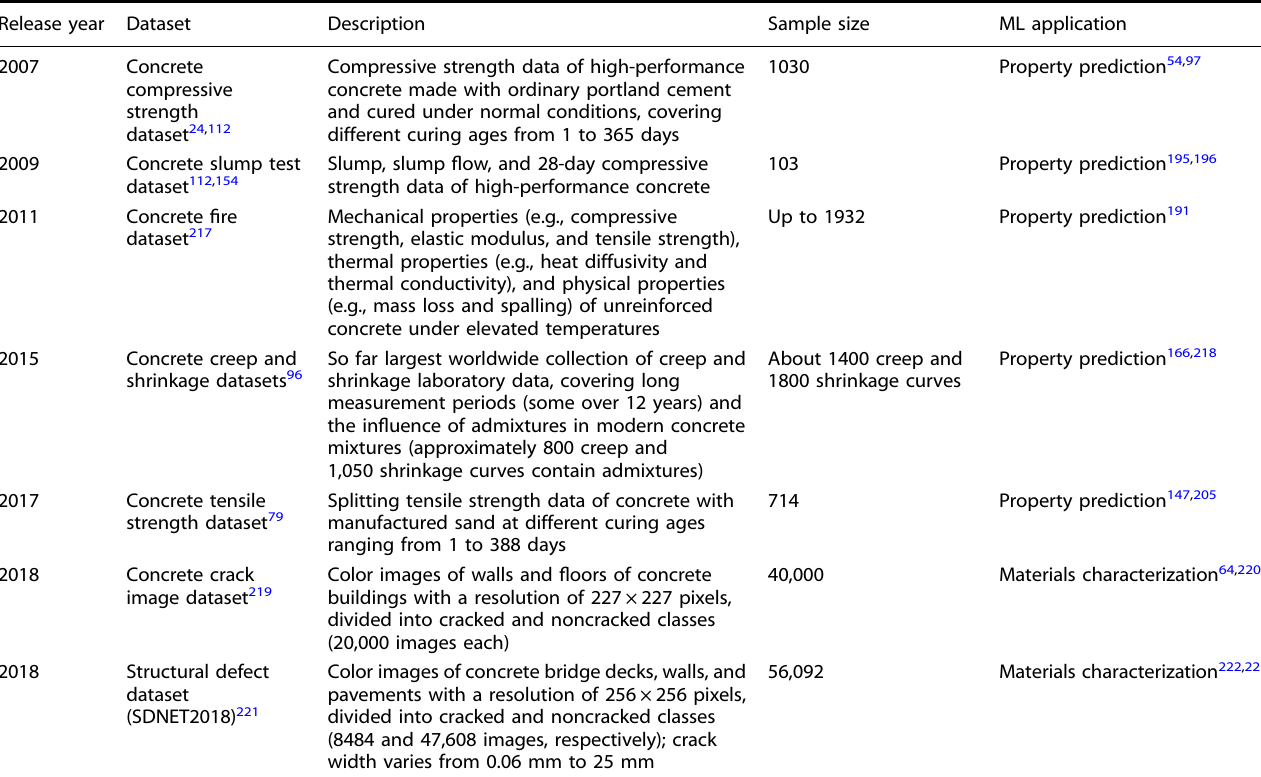
Table 2. Summary of publicly accessible datasets in concrete science for machine learning (ML)